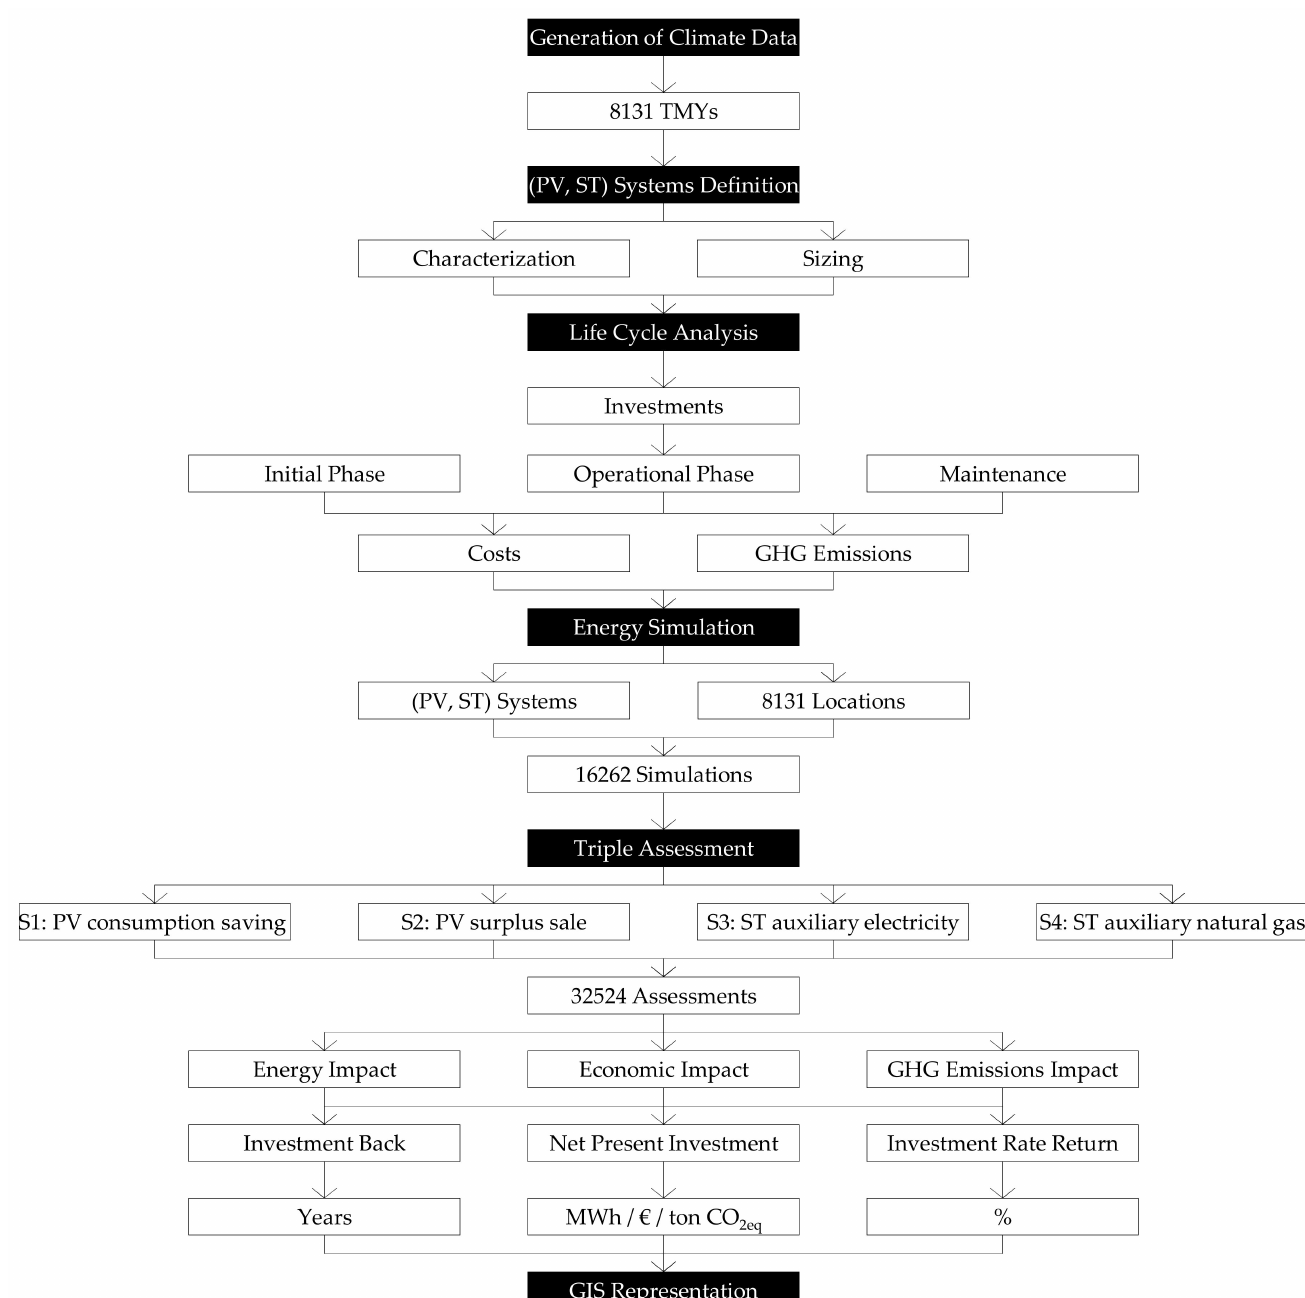
Figure 1. Research methodology